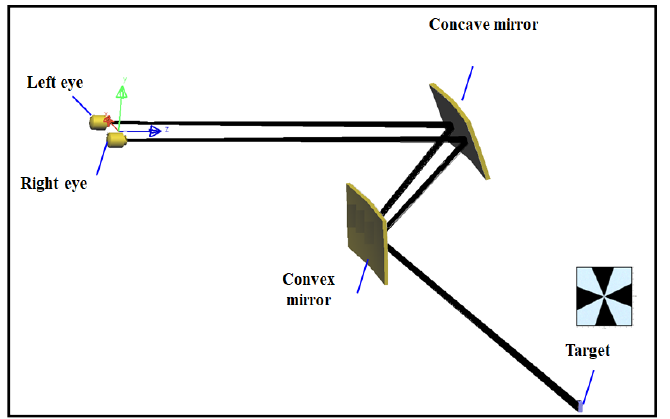
Figure 2. Optical layout of the double-mirror system built in the optical software, LightTools.